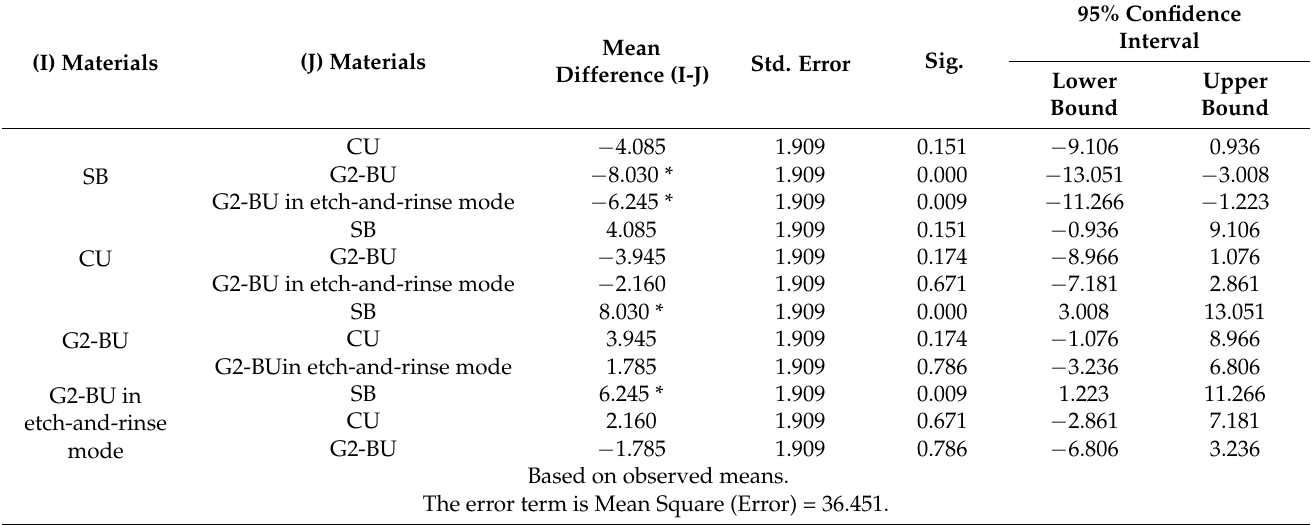
Table 2. The effect of multiple comparisons between studied